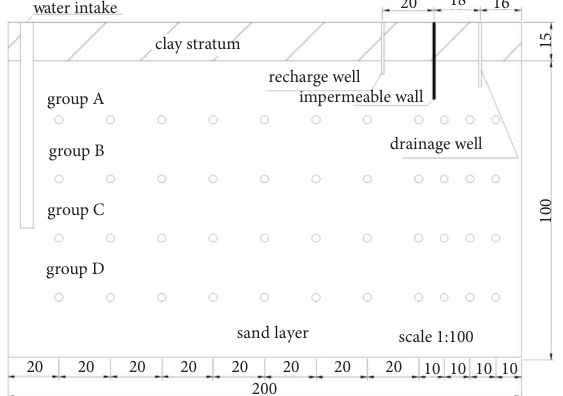
Figure 3: Schematic diagram of the recharging well, impermeable walls, and dewatering well (unit: cm).